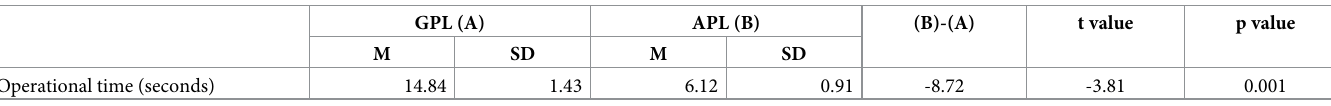
Table 4. Comparison of operational time of the GPL and the APL (N =